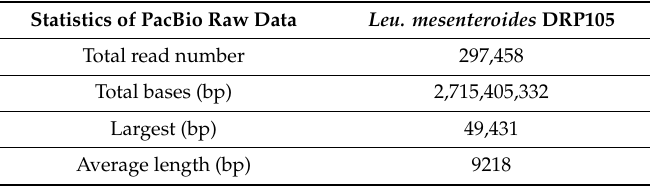
Table 1. Statistics table of PacBio raw data.